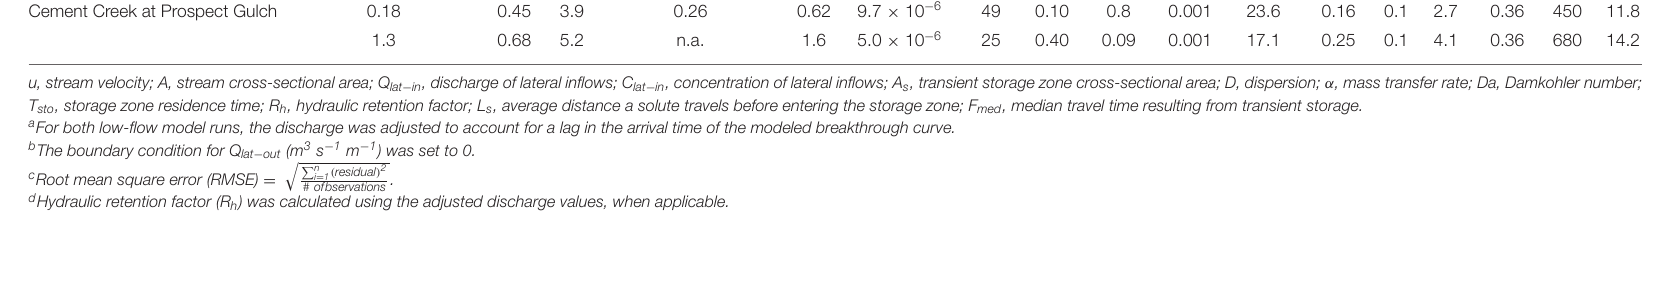
Mineral Creek at Chattanooga Cement Creek at Prospect Gulch